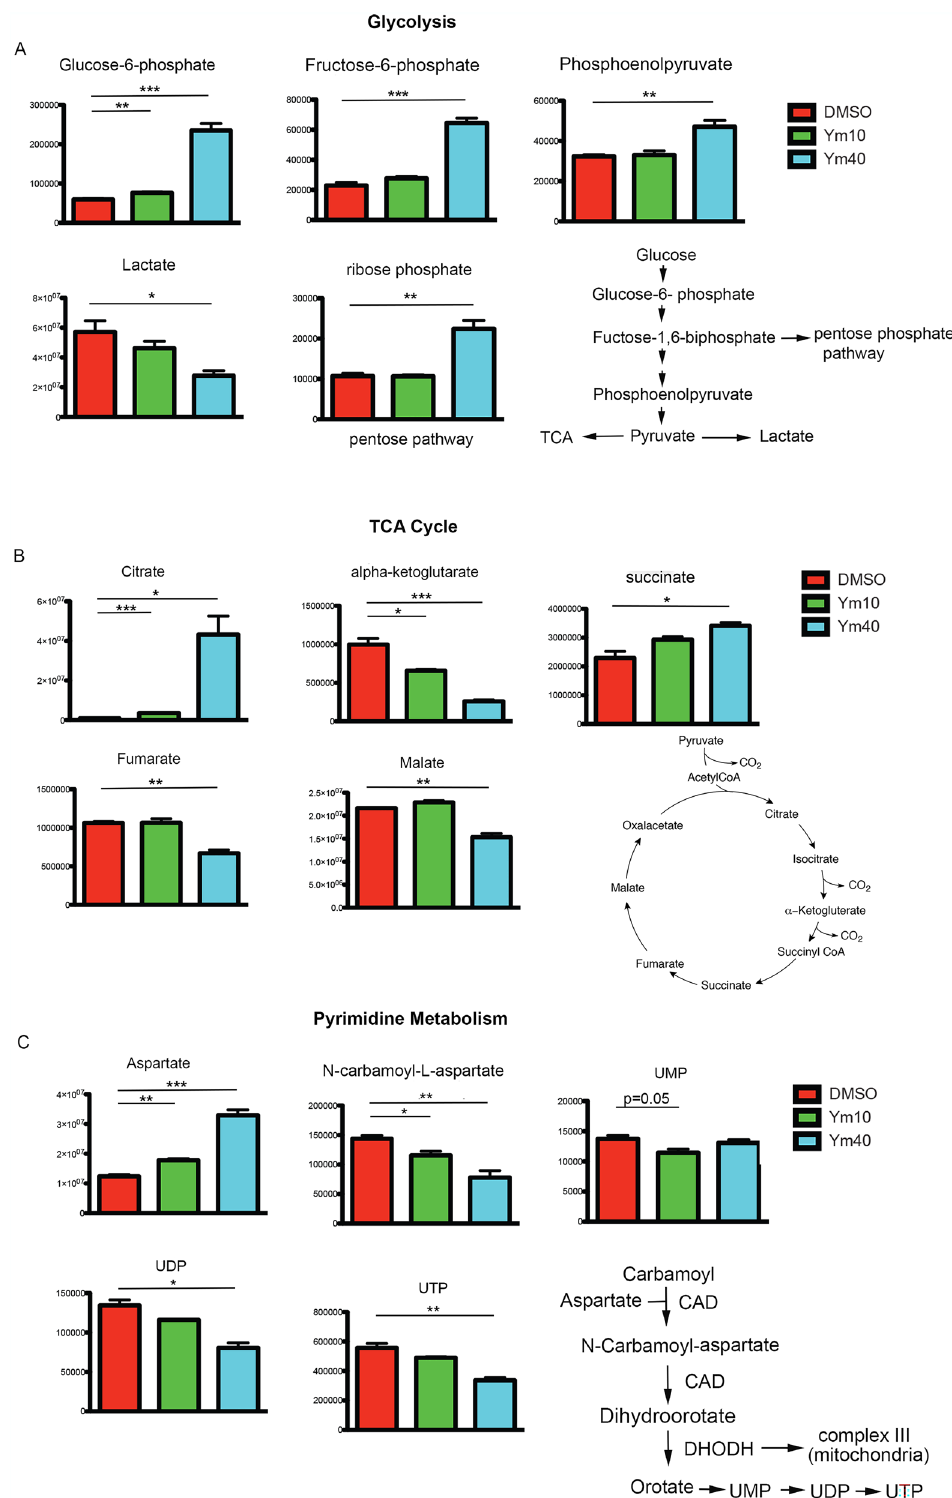
Figure 4. Ym155 decreases TCA cycle metabolite intermediates. Metabolite intermediates of glycolysis, TCA cycle, and pyrimidine intermediates were determined by MS/LS/MS of H1299 cells treated with Ym155 for 3 h. ( A ) Early and late glycolysis intermediates were increased with Ym155 as wells as the pentose pathway intermediate ribose phosphate. ( B ) TCA intermediates alpha-ketoglutarate, fumarate, and malate were decreased. Citrate and succinate metabolites were increased. ( C ) Pyrimidine intermediates were decreased following Ym155 treatment. CAD (carbamoyl aspartate dehydrogenase), DHODH (dihydroorotate dehydrogenase). * p < 0.05, ** p < 0.01, *** p <